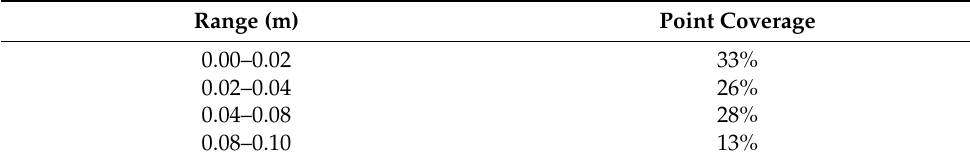
Table 9. C2C analysis L1–P1: point coverage related to a range of distances.